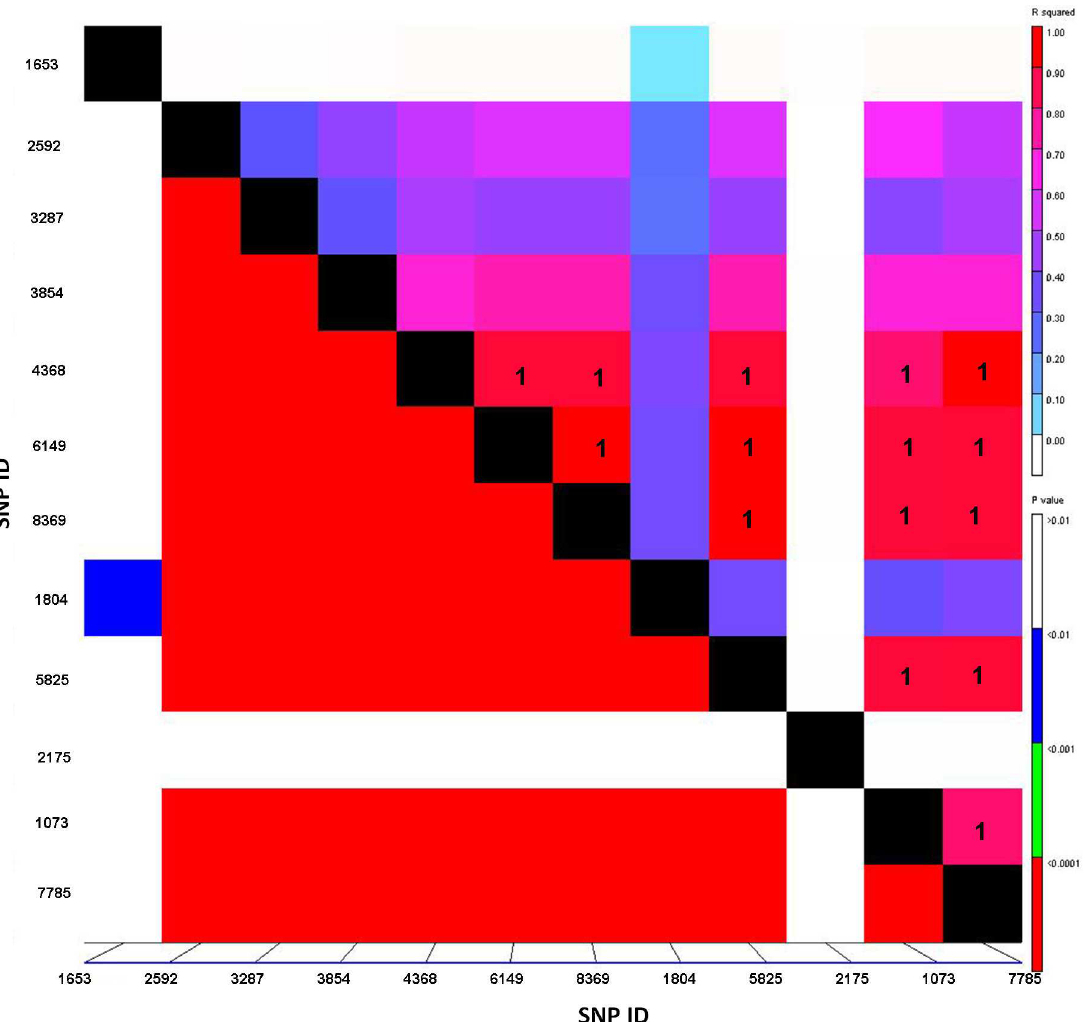
Fig 3. Linkage disequilibrium plots of significant SNP markersassociatedwith stem rust resistance. R square (R 2 ) and P-value of pair-wise analysesare indicatedby color in the right-side bars. The SNP pairs with R 2 value of “1” are indicated. The SNP IDs are presentedon the X and Y axis. The detailed informationfor the markers is shown in Table 1.